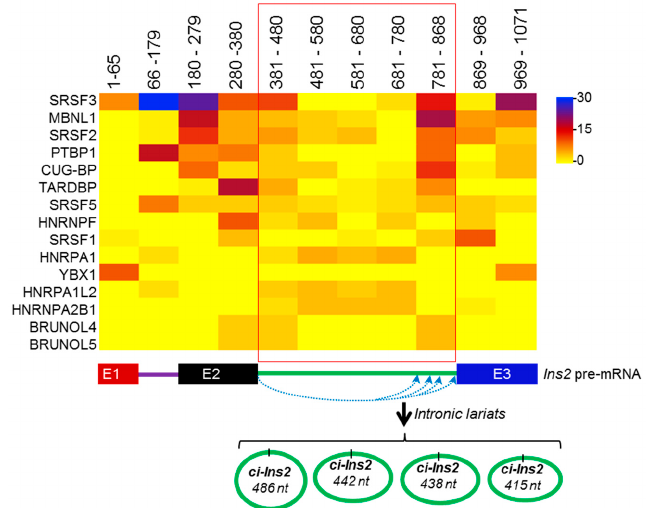
Figure 6. RNA-binding proteins (RBPs) predicted to associate with ci-Ins2 and Ins2 pre-mRNA. Heatmap of RBPs predicted by the beRBP algorithm to have ten or more number of binding sites on mouse Ins2 pre-mRNA ( top ). The scale bar colors represent the number of binding sites on the specific region of Ins2 pre-mRNA. Schematic representation of biogenesis of multiple ciRNAs from Ins2 pre-mRNA ( bottom ). Straight lines and boxes represent introns and exons, respectively. The blue dotted arrows represent alternate intron lariat formation, generating multiple ci-Ins2 transcripts.